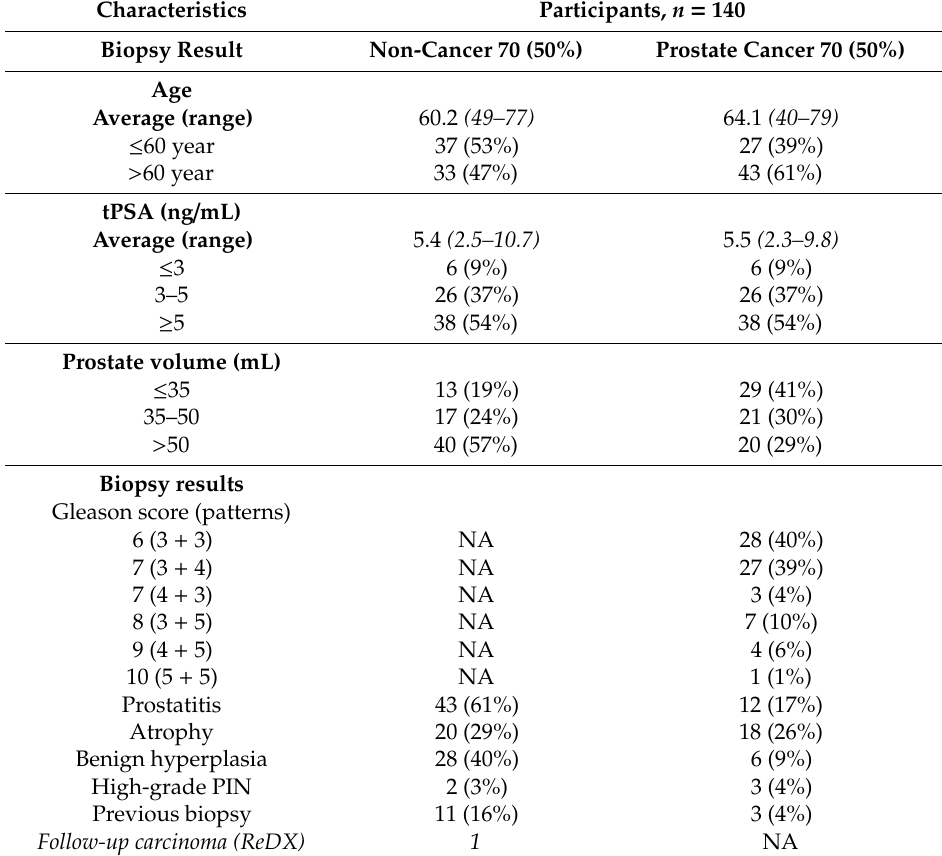
Table 1. Characteristics of cancer and non-cancer participants included in this